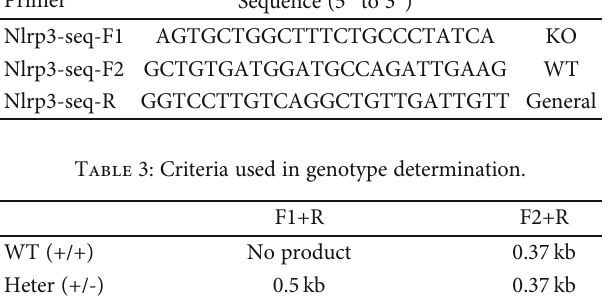
Table 5: Groups of VMC mice treated with anti-IL-1 β antibody. Groups